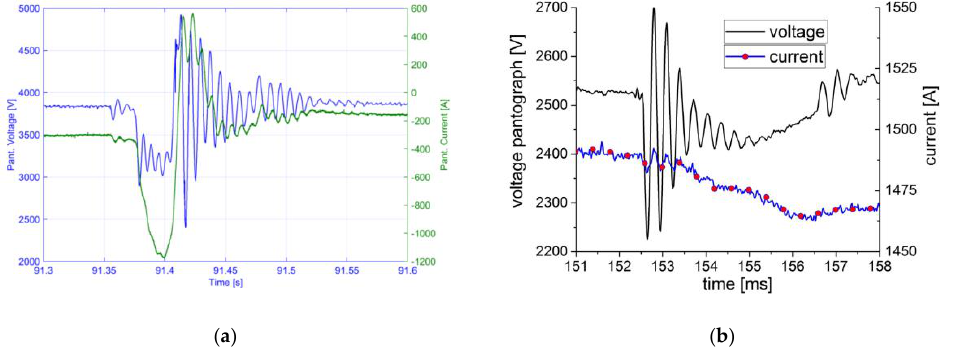
Figure 13. Measured transient voltage and currents in 3 kV DC ERPS. ( a ) Pantograph voltage and ripple index caused by changes in operational conditions [104]. ( b ) Pantograph voltage and current during oscillatory transients (OsT) caused by sliding/jump effect [103].